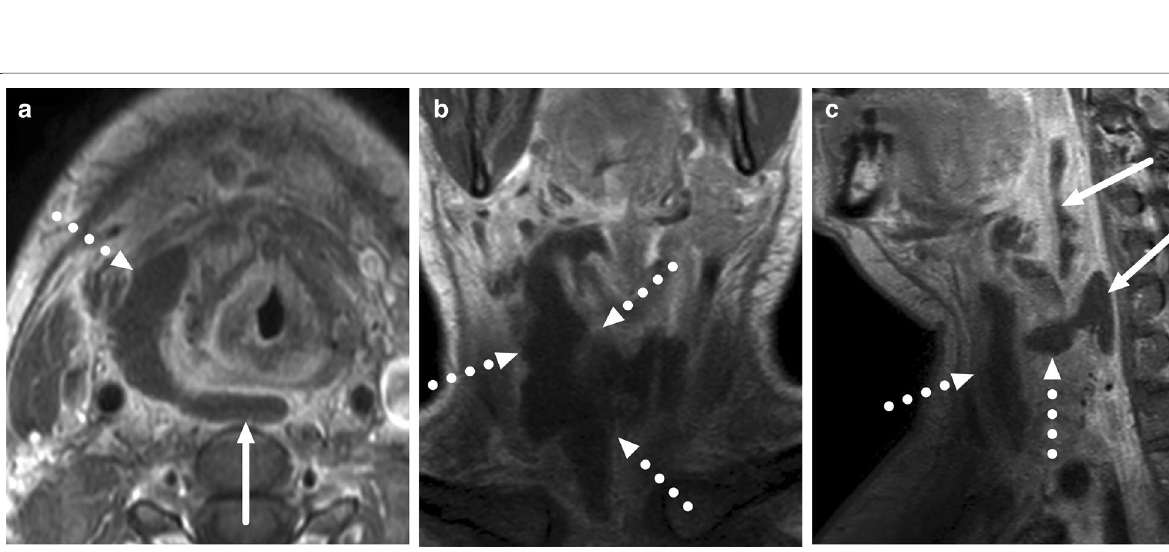
Fig. 8 Multi-space abscess on axial ( a ), coronal ( b ), and sagittal ( c ) post-contrast T1-weighted images. A pharyngotonsillar infection was complicated by a large abscess affecting the retropharyngeal (arrows) and visceral and anterior cervical (dotted arrows)